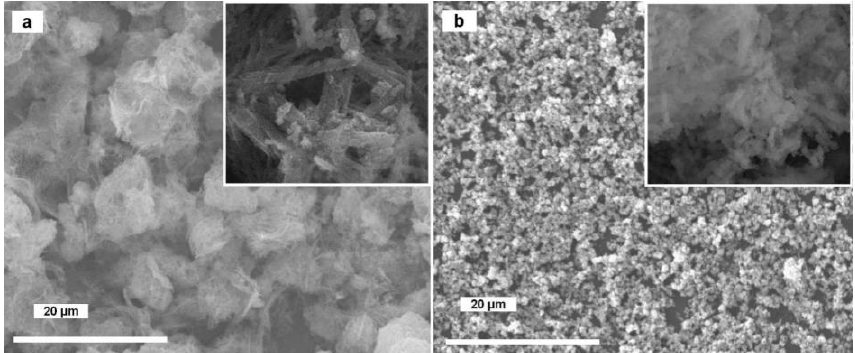
Figure 6. SEM images of as-prepared Cu 3 N powders: ( a ) sample ( 2b ) (CuO) and ( b ) sample ( 3b ) (Cu(OH) 2 ) after ammonolysis (4 h, 300 °C). The inset shows a view of the samples magnified 150,000×.